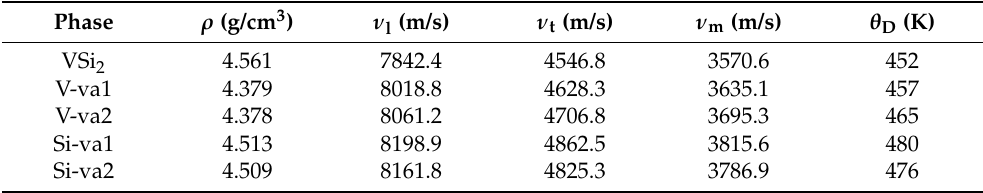
Table 8. The density ρ , sound velocities (longitudinal ν l , transverse ν t and mean ν m ) and Debye temperature θ D